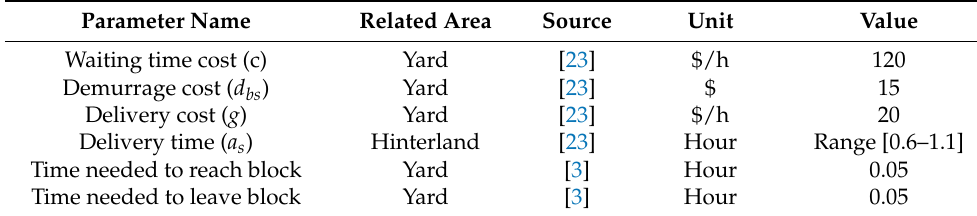
Table 9. A summary of the input parameters values.